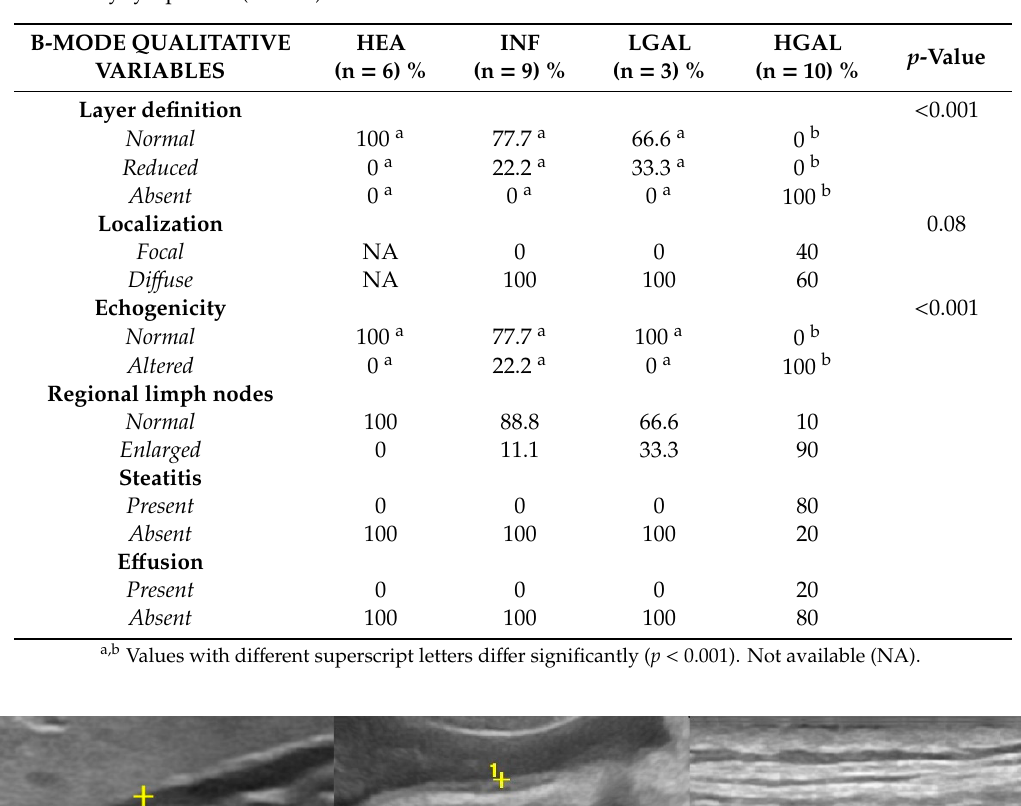
Table 2. Number of cases ( n ) and percentage (%) showing qualitative features at B-mode ultrasound for healthy (HEA), inflammatory (INF), low-grade alimentary lymphoma (LGAL) and high-grade alimentary lymphoma (HGAL).